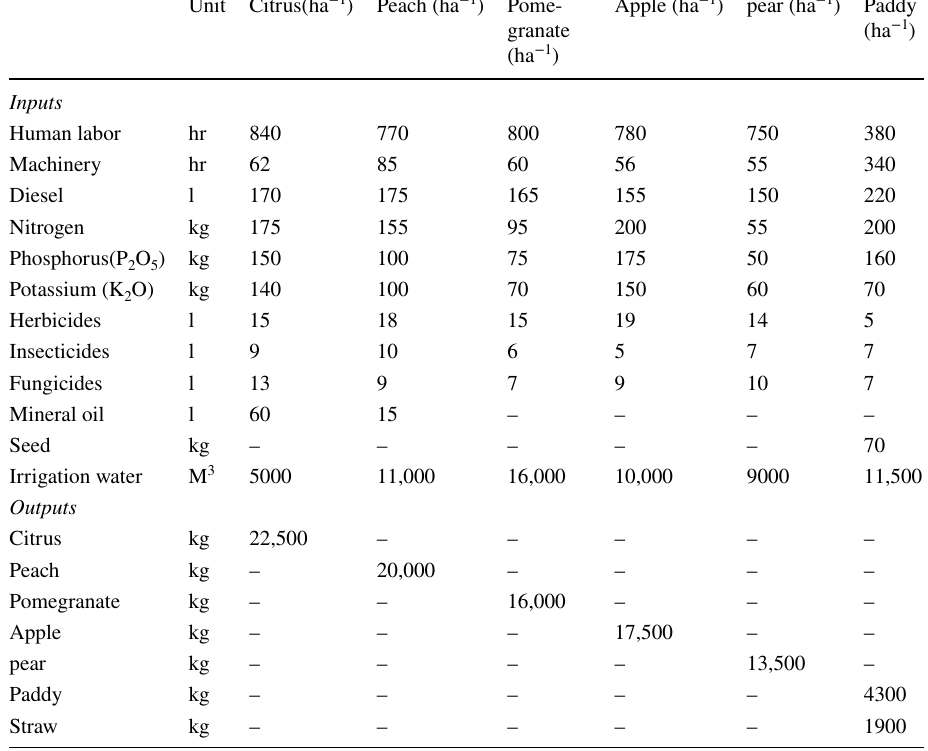
Table 3 Input and output values of inputs in the production of studied products in Tajan